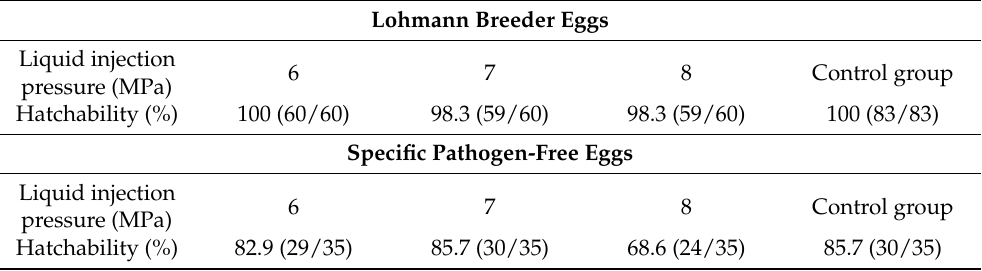
Table 3. Hatching rates of Lohmann and specific pathogen-free embryonic eggs injected with saline at different liquid jet